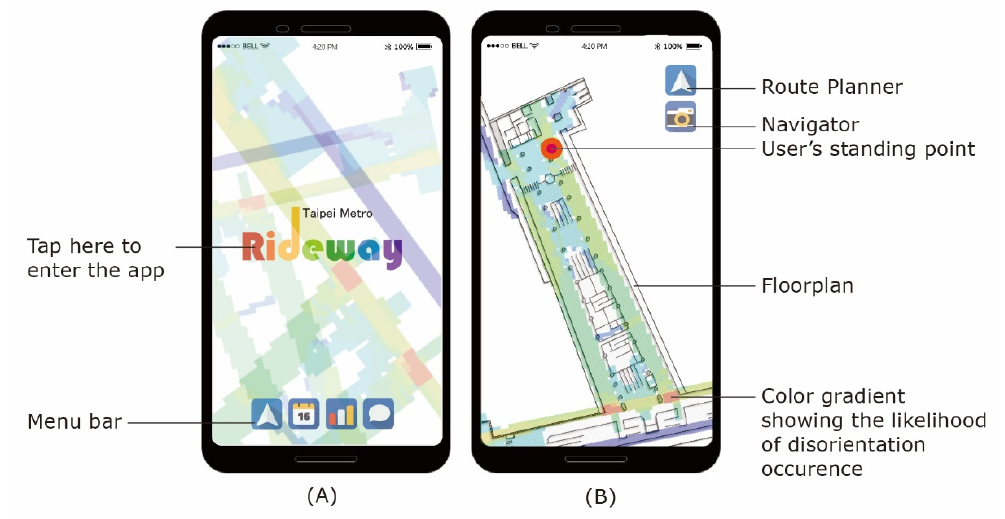
Figure 5. Interface of Rideway: ( A ) Home page and ( B ) Interactive map guiding the user to avoid disorientation.